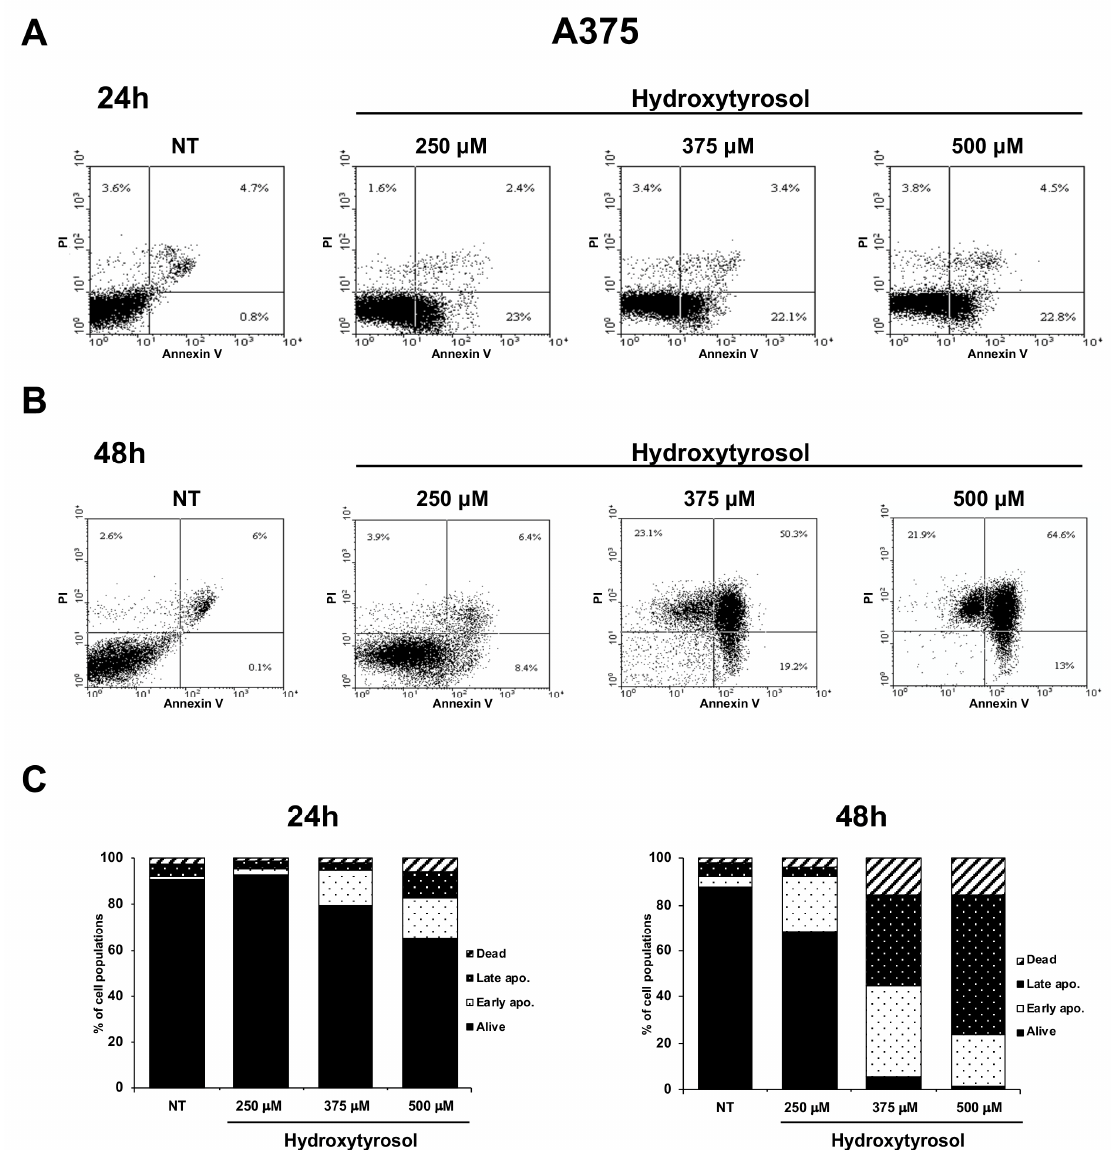
Figure 3. Flow cytometric analysis of A375 melanoma cells treated with hydroxytyrosol. A375 cells untreated (NT) or treated for 24 h ( A ) and 48 h ( B ) with 250 µ M, 375 µ M, and 500 µ M of hydroxytyrosol were analysed by annexin V-FITC / PI staining through flow cytometry. The percentage of cells alive (lower left quadrant), early apoptotic cells (lower right quadrant), late apoptotic cells (upper right quadrant), and necrotic cells (upper left quadrant) were reported in flow cytometric graphics. The graphics of flow cytometric analysis are representative of several independent experiments. The percentage of early apoptotic, late apoptotic, and necrotic A375 cells, untreated (NT) or treated for 24 h (left graphic) and for 48 h (right graphic) with hydroxytyrosol, as mean values of several di ff erent experiments are reported in the histograms ( C